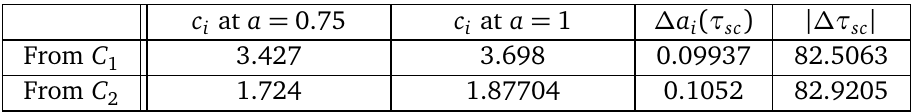
Table 7: Estimated lower bound scrambling time scales for the region of rise due to lack of saturation region for the exponential model from the two different complex-